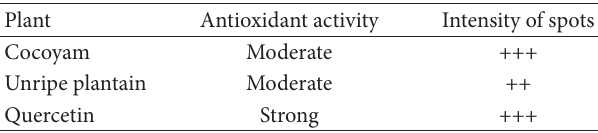
Table 7: Free radical scavenging activities of the methano- lic/ethanolic extracts of cocoyam and unripe plantain incorporated feeds using rapid DPPH TLC screening.